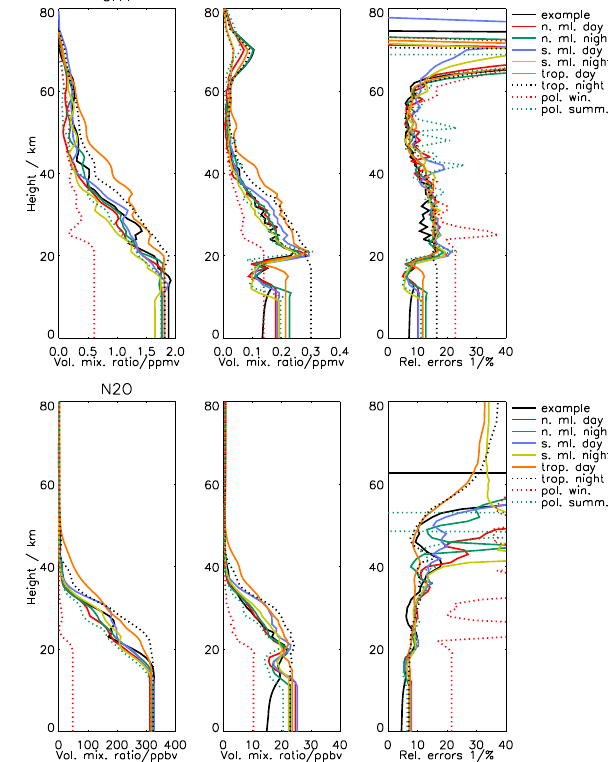
1 Figure 15. Profiles and total errors calculated from error budgets for different atmospheric conditions measured during the reduced- resolution period. Left panels: profiles, middle panels: absolute to- tal errors, right panels: relative total errors. The colours indicate the atmospheric conditions annotated in the legend. The black curves titled “example” are for the error budget shown in Fig. 11. The up- per panels show results for CH 4 ; the lower panels show results for Figure 14. As Fig. 11, but for the measurement in orbit 10324 at N 2 1 46.0 ◦ N, 144.5 ◦ W on 20 February 2004, 07:48:31UTC (version V5H_N2O_21).